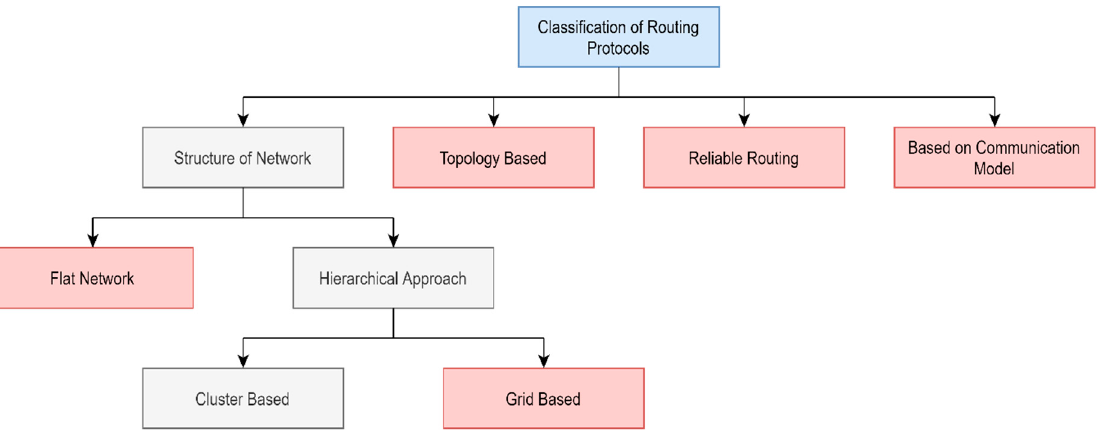
Figure 1. Classification of routing protocols in WSN (The scope of this paper covers grey colored boxes only)